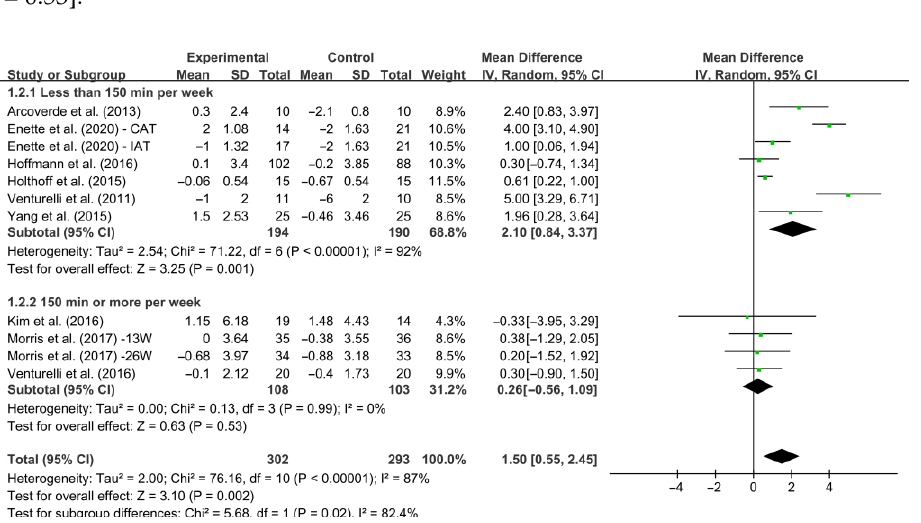
Figure 6. Meta-analysis results of the effect of the duration of intervention per week on cognitive function in AD patients [20,27,39 – 45].